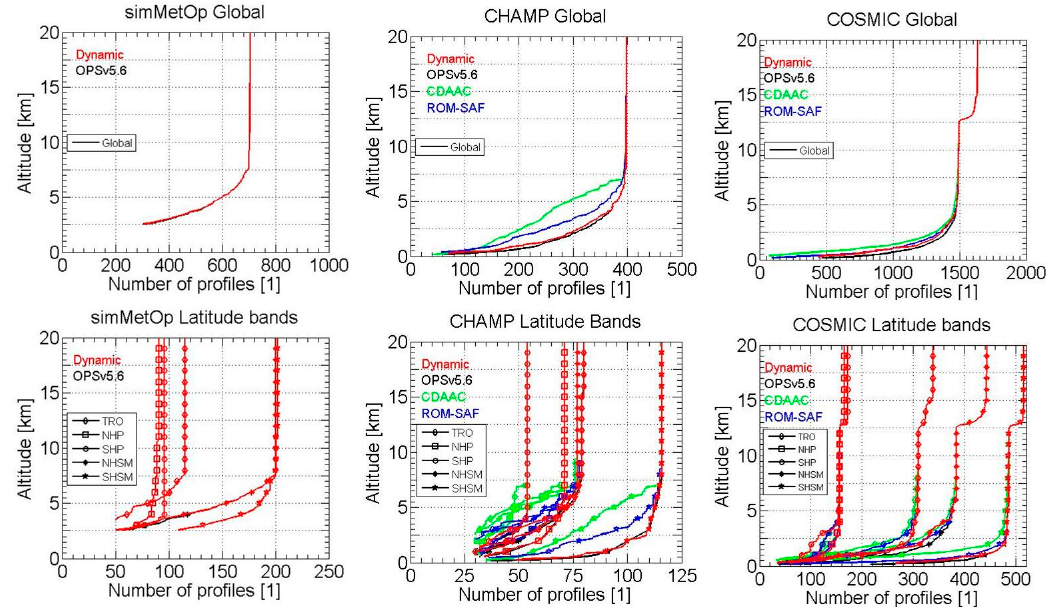
Figure 6. Number of RO profiles from simMetOp (left), CHAMP (middle), and COSMIC (right) as function of altitude for the global domain (top row) and five latitudinal bands (bottom row), including TRO (tropics; 20°S to 20°N), NHP (northern hemisphere polar; 60°N to 90°N), SHP (southern hemisphere polar; 60°S to 90°S), NHSM (northern hemisphere subtropics and mid-latitudes, 20°N to 60°N), and SHSM (southern hemisphere subtropics and mid-latitudes, 20°S to 60°S), on 15 July 2008 for simMetOp and COSMIC and on 14-16 July 2008 for CHAMP. The red, black, green, and blue colors denote the dynamic, OPSv5.6, CDAAC, and ROM-SAF approaches, respectively, with the dynamic one plotted last (hence shadowing other colors above the lower to middle troposphere) and the profiles for different latitude bands denoted by distinct symbols (see legend).